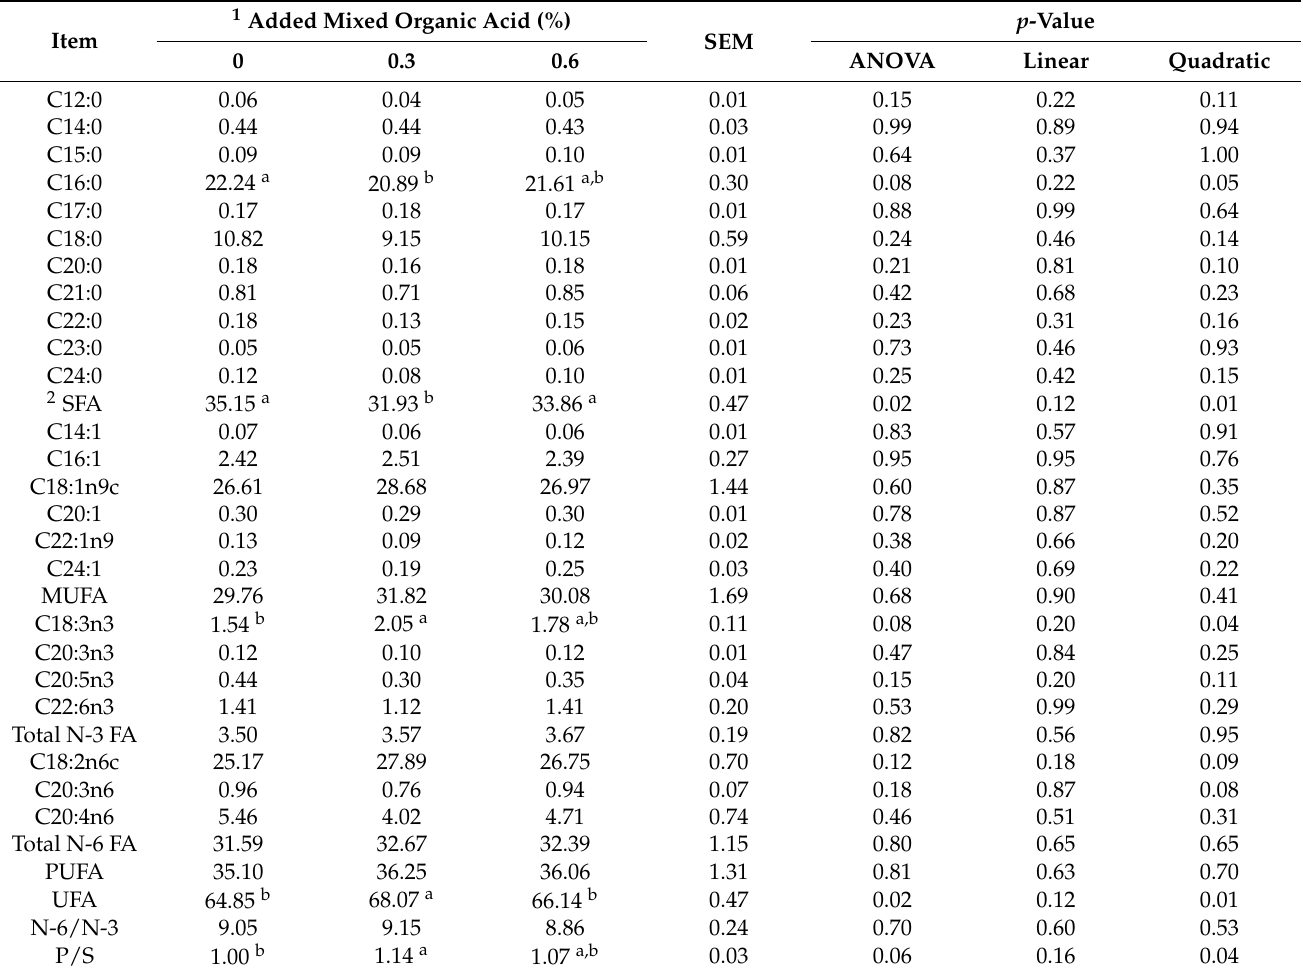
Table 4. Fatty acids composition in breast muscle of broiler chickens as affected by dietary MOA supplementation (g/100 g total fatty acids,